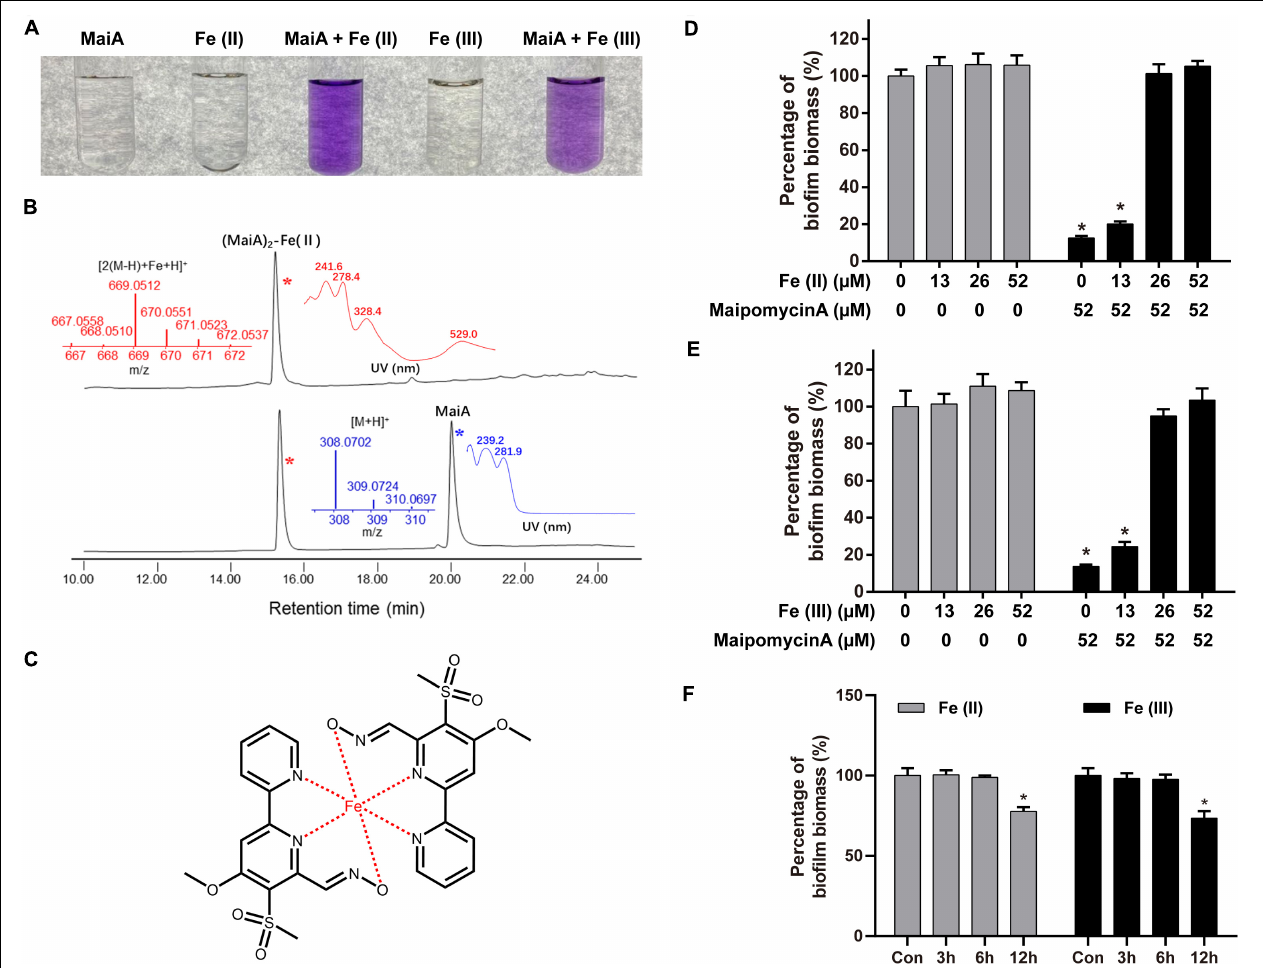
FIGURE 4 | Maipomycin A (MaiA) is an iron chelator. (A) Mili-Q water containing MaiA (final concentration at 0.1 mM) treated with Fe(II) or Fe(III) ions (final concentration both at 0.05 mM). (B) HPLC analysis (DAD at 244 nm) of the solutions containing MaiA and FeSO 4 at molar ratios of 2:1. Mass and DAD profiles of MaiA and the (MaiA) 2 -Fe(II) complex are presented in blue and red colors, respectively. (C) Putative structure of (MaiA) 2 -Fe complex. (D,E) Biofilm formation by A. baumannii ATCC 19606 was measured in the presence or absence of iron with (black) or without (gray) the treatment of MaiA. Both Fe(II) and Fe(III) ions were added at the beginning of the incubation. (F) MaiA (final concentration at 52 µ M) was added to the cultures initially, then Fe(II) or Fe(III; final concentration both at 26 µ M) was added after 3, 6, and 12 h, respectively. *Indicates P < 0.05 compared with untreated controls